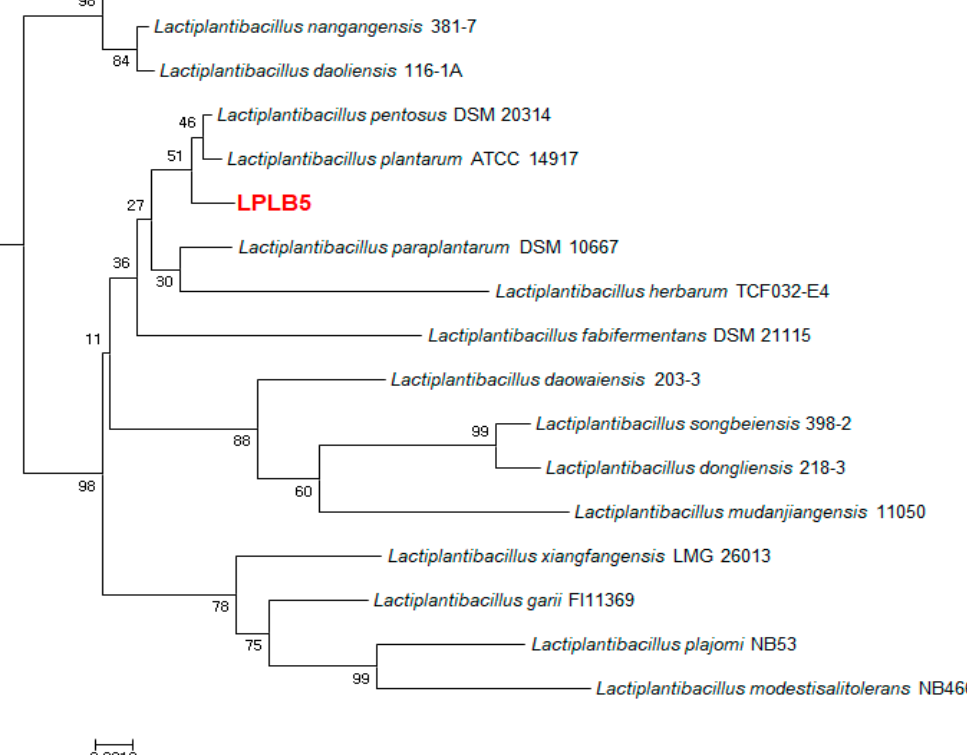
Figure 3. Neighbor-joining phylogenetic tree constructed based on 16S rRNA gene sequencing. The position of strain LPLB5 and its closest members of the genus Lactiplantibacillus were shown. Bootstrap percentages ( ≥ 30%) based on 1000 replications are given at the branch points. Bar, 0.01 substitutions per nucleotide position.